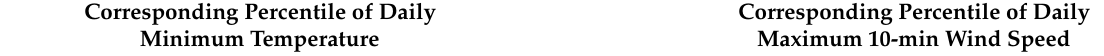
Table 7. Percentile position of threshold values of T and w in daily minimum temperature and daily maximum 10-min wind speed in cool months and all months of 1991–2020. Corresponding Percentile of Daily Minimum Temperature